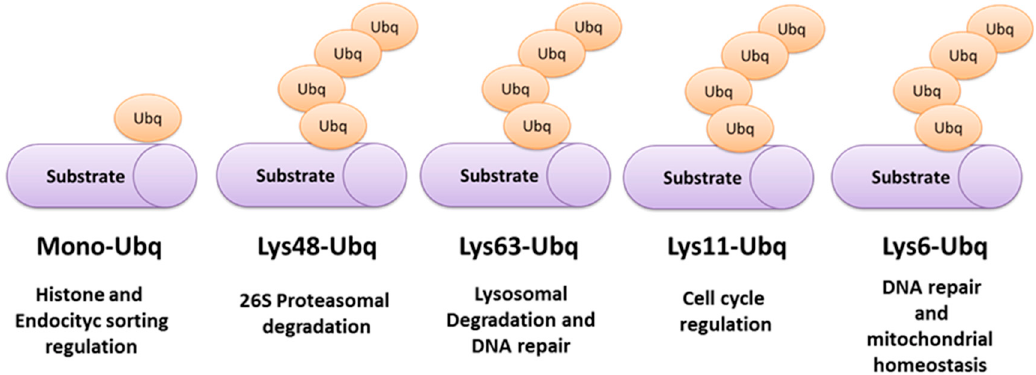
Figure 2. The ubiquitin post-translational modifications, either mono- or poly-ubiquitination, direct the conjugated substrates to different cellular fates which depend from the length and the type of ubiquitin chain.